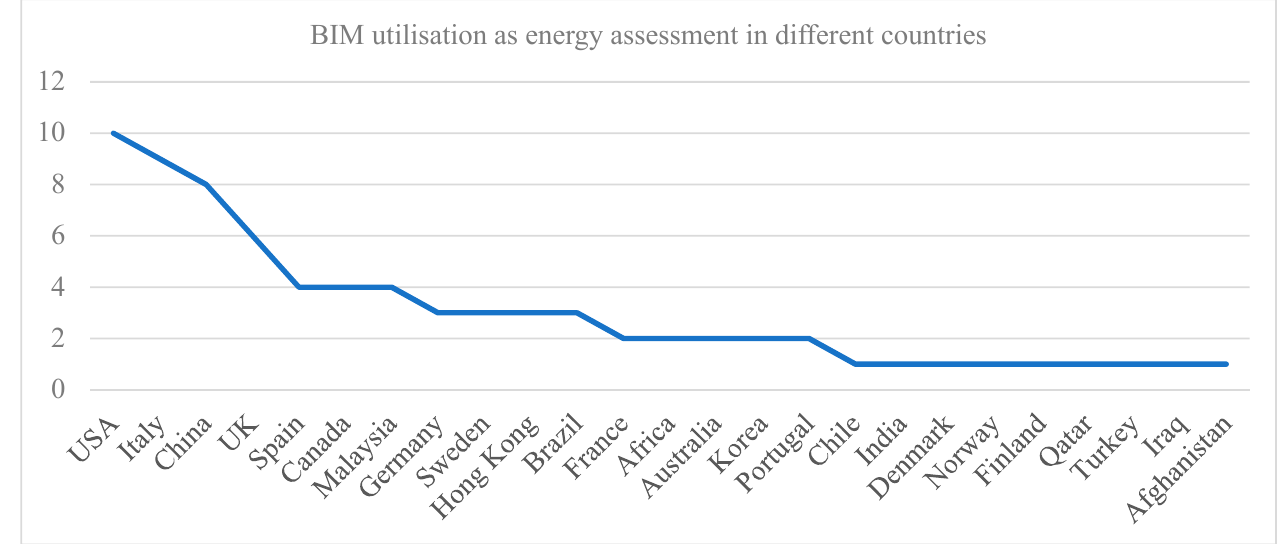
Figure 2. BIM application for energy assessment in different countries.